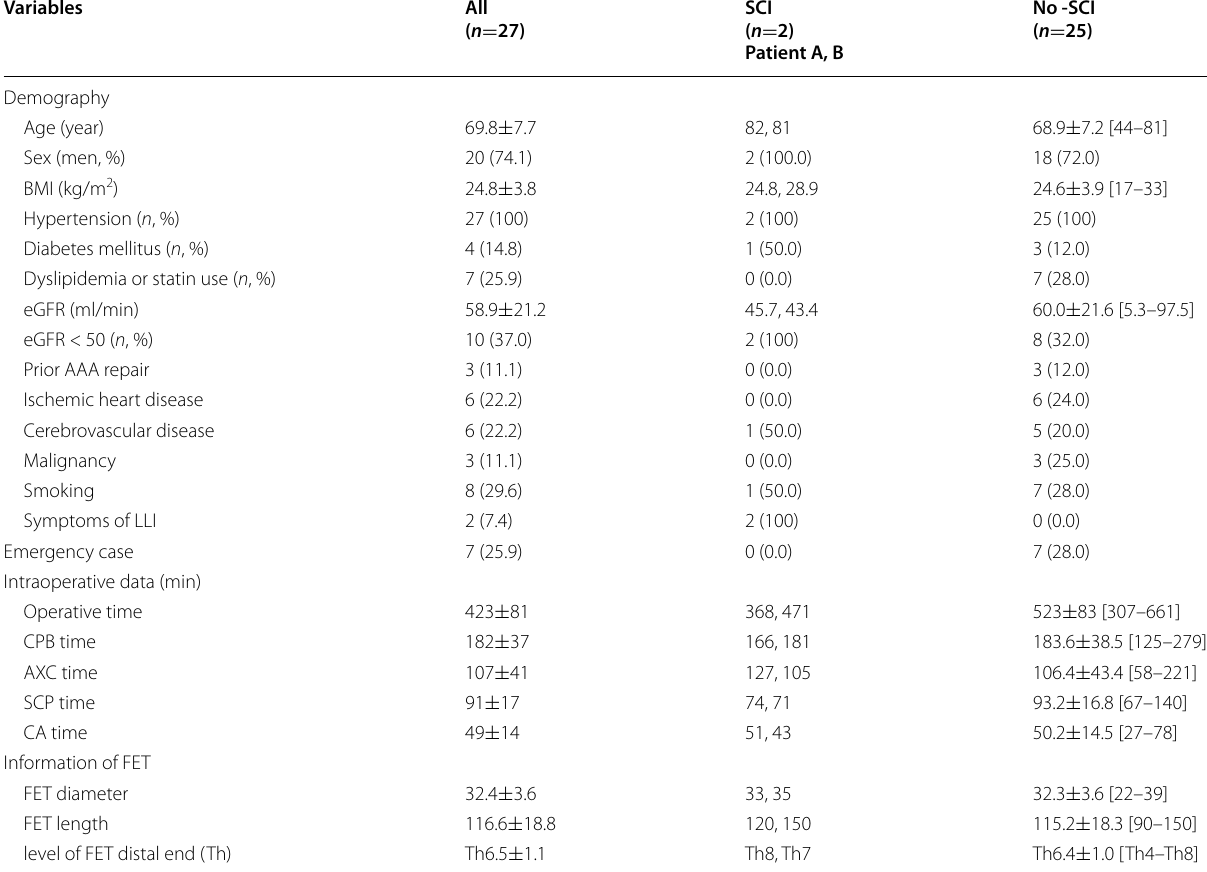
Table 1 Patient demography and perioperative